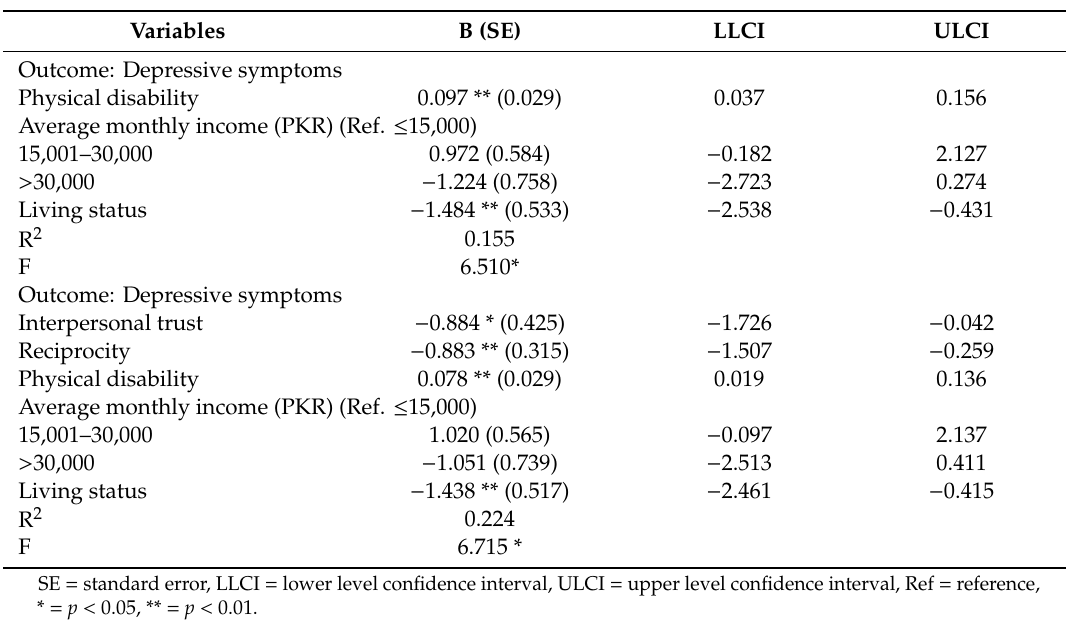
Table 4. Mediation effect based on PROCESS model 4.